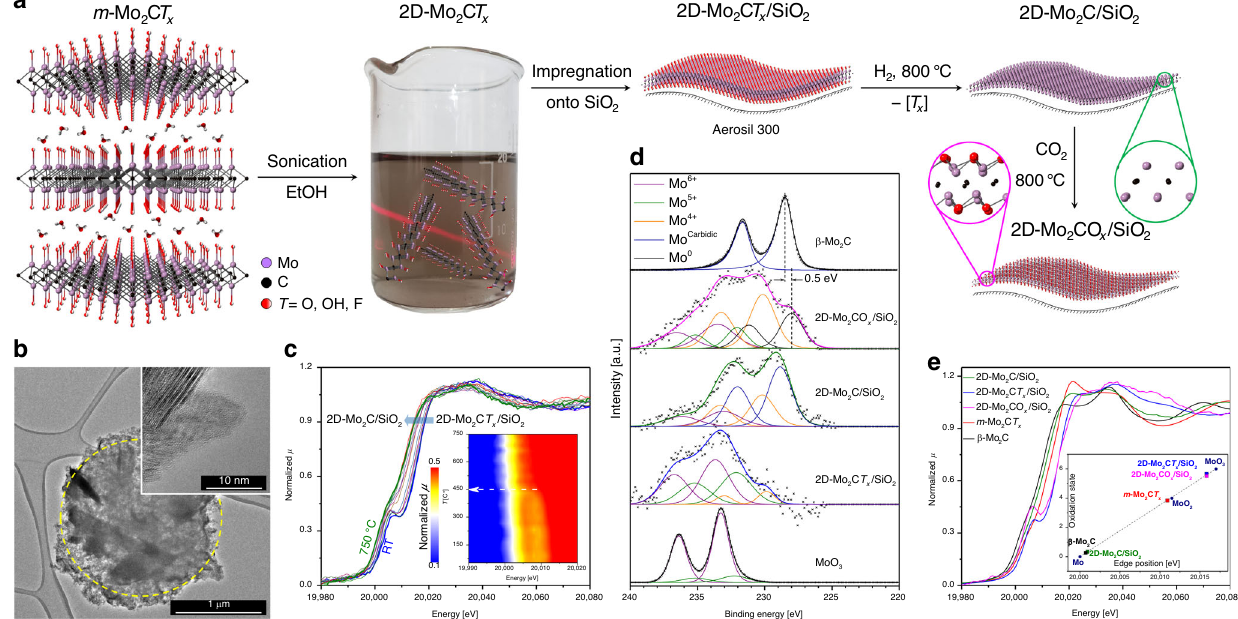
Fig. 1 Synthesis and characterization of 2D-Mo 2 CO x /SiO 2 . a Synthesis of 2D-Mo 2 CO x /SiO 2 from delaminated Mo 2 C T x fi lms via incipient wetness impregnation of their colloidal solution onto silica, followed by the reduction of the T x groups under H 2 (giving 2D-Mo 2 C/SiO 2 ) and the subsequent oxidation in CO 2 (giving 2D-Mo 2 CO x /SiO 2 ); b TEM images of 2D-Mo 2 C T x /SiO 2 ; c in situ reduction of 2D-Mo 2 C T x /SiO 2 under H 2 as followed by Mo K -edge XANES revealing an evolution of the pre-edge feature with temperature (shown in the inset as a contour plot); d oxidation state of Mo in reference and synthesized materials determined from the deconvolution of ex situ XPS data of the Mo 3 d core levels as well as from e the edge position in XANES spectra.